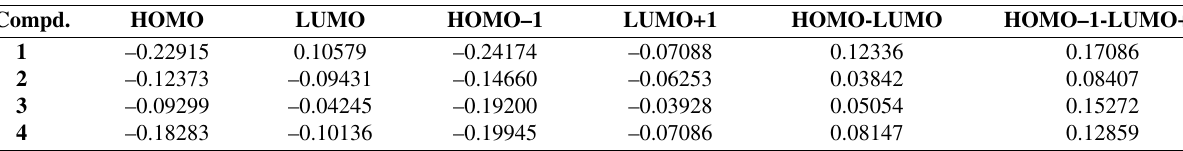
Table 3. HOMO, HOMO–1, LUMO, LUMO+1 and Δ E energies (a.u.)